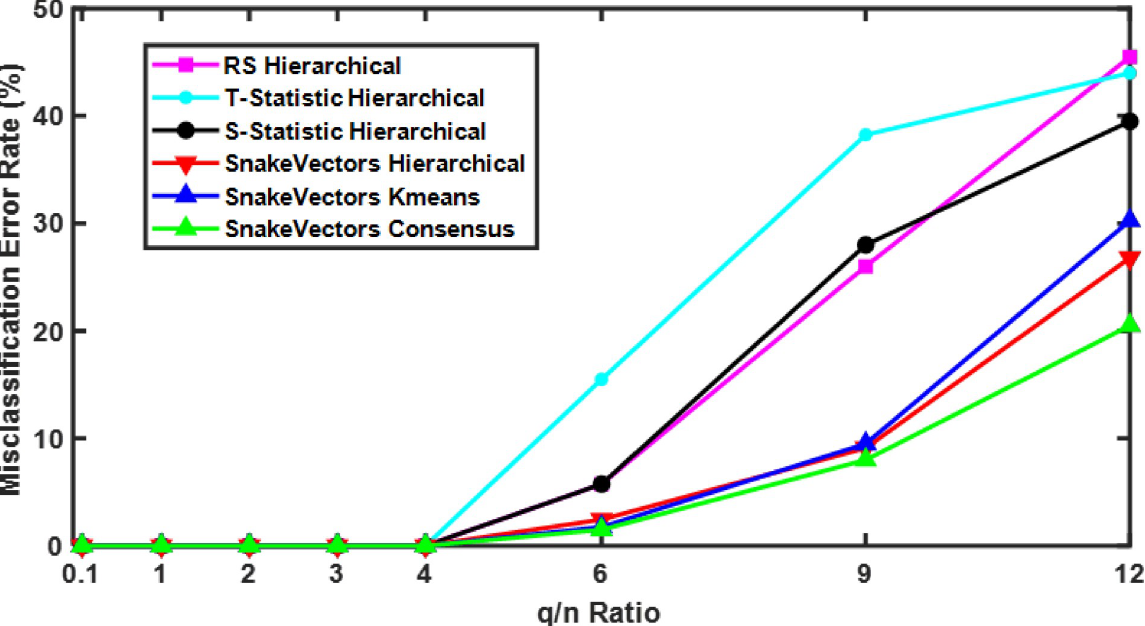
Fig 7. Misclassification error in clustering of simulated connectivity matrices. Comparison of hierarchical clustering results for RS, T- and S- statistics, and snakes vectors, with k-means and resampling-based consensus clustering using snake vectors. Snake vectors based approaches outperform RS, T- and S-statistics based ones. Red, blue, and green curves demonstrate that the main advantage is due to the use of snake vectors, not due to the type of clustering algorithm used.